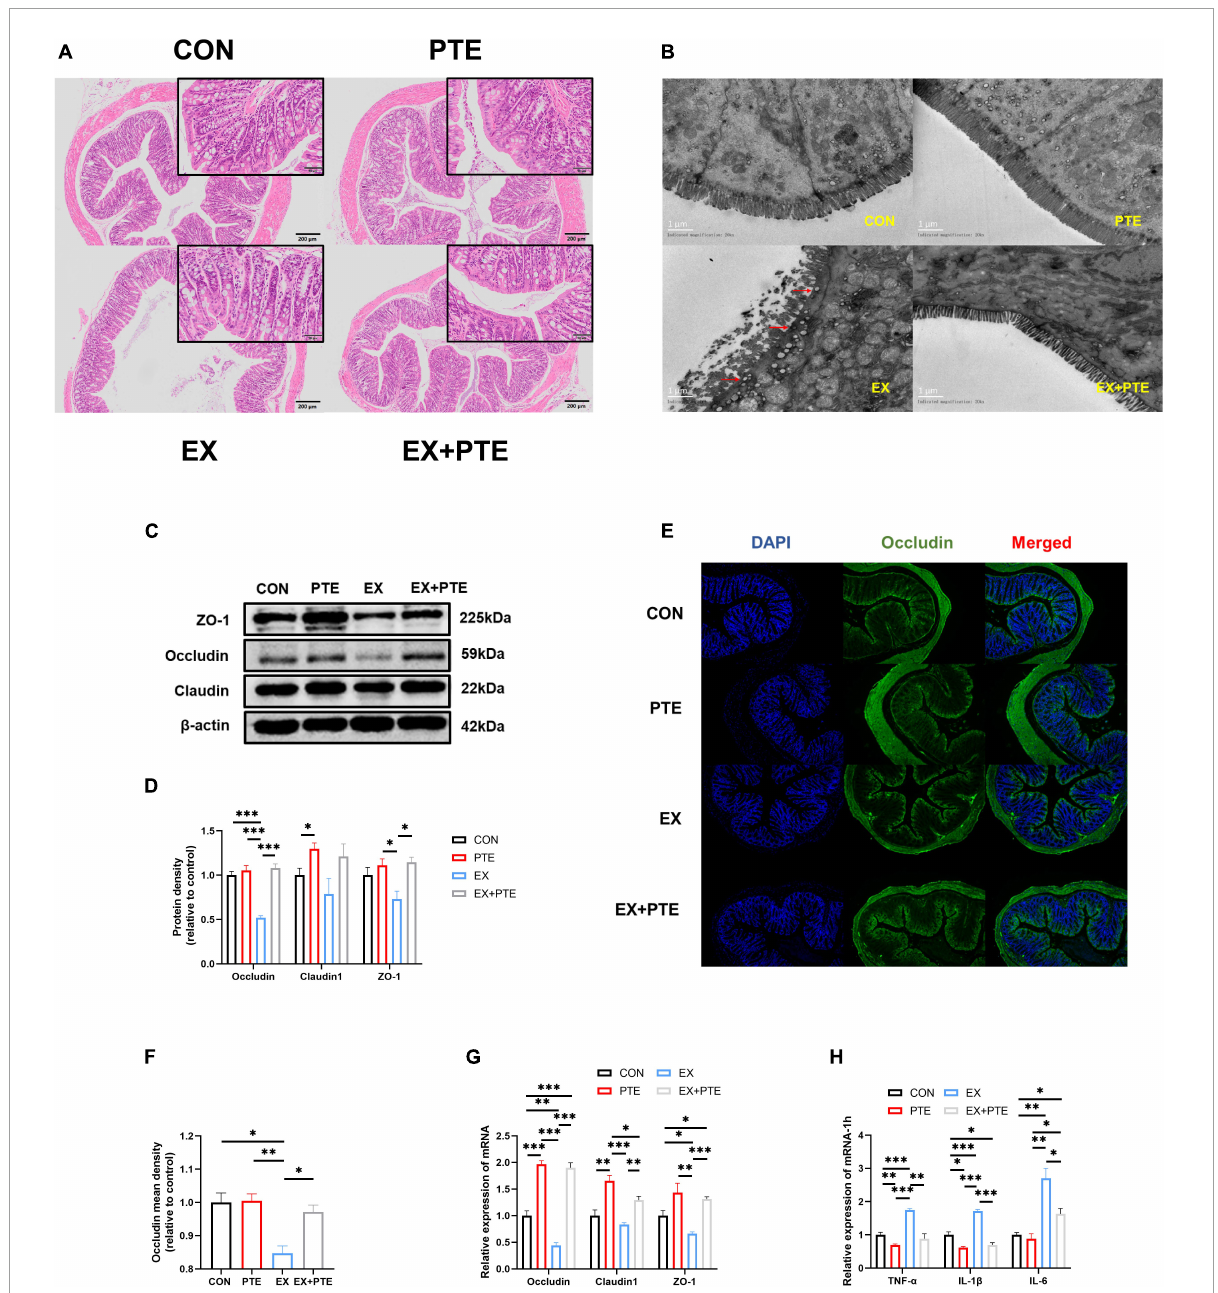
FIGURE2 PTE (100 mg/kg/d) inhibited exercise-induced intestinal injury. (A) Histological staining of the colon. (B) Transmission electron microscopy. (C,D) Protein levels of TJ were analyzed by western blotting (occludin: PTE: F = 51.611, p < 0.001; EX: F = 28.061, p < 0.001; interaction: F = 34.992, p < 0.001.Claudin1: PTE: F = 8.435, p < 0.05; EX: F = 1.431, p = 0.266; interaction: F = 0.269, p = 0.618.ZO-1: PTE: F = 11.587, p < 0.01; EX: F = 2.287, p = 0.169; interaction: F = 3.893, p = 0.084). (E,F) Colon was observed by the immunofluorescence staining (PTE: F = 7.793, p < 0.05; EX: F = 16.164, p < 0.01; interaction: F = 6.612, p < 0.05). The expression of the intestinal barrier (G) (occludin: PTE: F = 245.310, p < 0.001; EX: F = 16.339, p < 0.01; interaction: F = 9.892, p < 0.01. Claudin1: PTE: F = 43.313, p < 0.001; EX: F = 9.654, p < 0.01; interaction: F = 1.303, p = 0.276.ZO-1: PTE: F = 26.905, p < 0.001; EX: F = 4.891, p < 0.05; interaction: F = 1.061, p = 0.323) and the inflammatory factor (H) (TNF- α : PTE: F = 44.853, p < 0.001; EX: F = 28.804, p < 0.001; interaction: F = 10.280, p < 0.01.IL-1 β : PTE: F = 125.588, p < 0.001; EX: F = 40.647, p < 0.001; interaction: F = 25.763, p < 0.001.IL-6: PTE: F = 10.094, p < 0.01; EX: F = 42.662, p < 0.001; interaction: F = 6.593, p < 0.05) were measured by qPCR. Data were expressed as means ± SEM, and the statistical significance was showed using asterisks denote ( ∗ p < 0.05; ∗∗ p < 0.01; ∗∗∗ p <